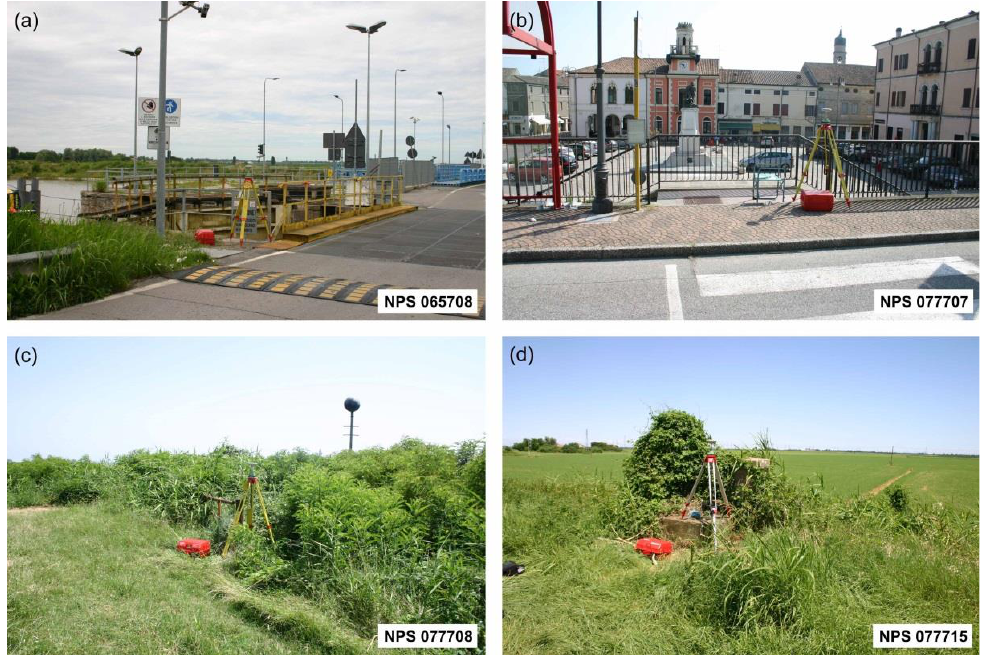
Figure 4. Examples of NPS sites of the PODELNET network located in urbanized ( a , b ) and vege- tated ( c , d ) areas.